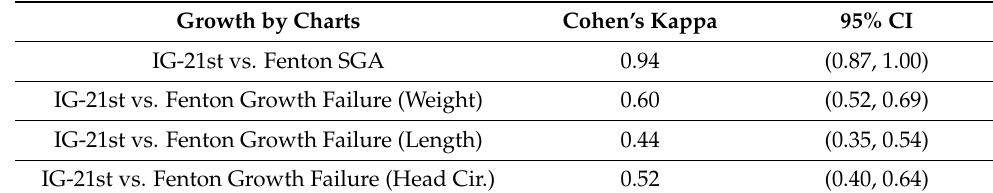
Table 3. Agreement in prevalence of growth failure by chart.